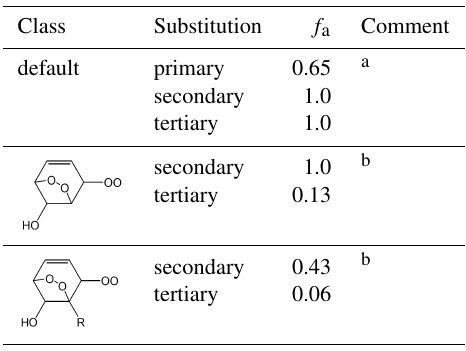
Table 2. Values of the scaling factor, f a , applied to the branching ratio calculation for the reaction of RO 2 with